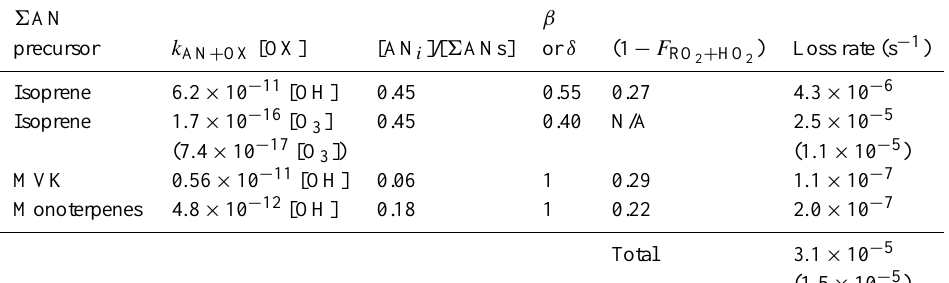
Table 2. Median oxidation rates calculated using the assumptions from the text. Here k AN + OX refers to the rate of reaction with the class of organic nitrates with either OH or O 3 , β and δ refer to the NO x recycling following reaction with OH or O 3 , respectively, and (1 − F RO refers to the fraction of RO 2 reactions that lead to NO x recycling (i.e. the fraction of the time RO 2 reacts with either NO or other RO 2 ). The two numbers listed for the isoprene+O 3 rate reflect the range in possible β -hydroxy isoprene nitrate ozonolysis rates. 6 AN β precursor k AN + OX